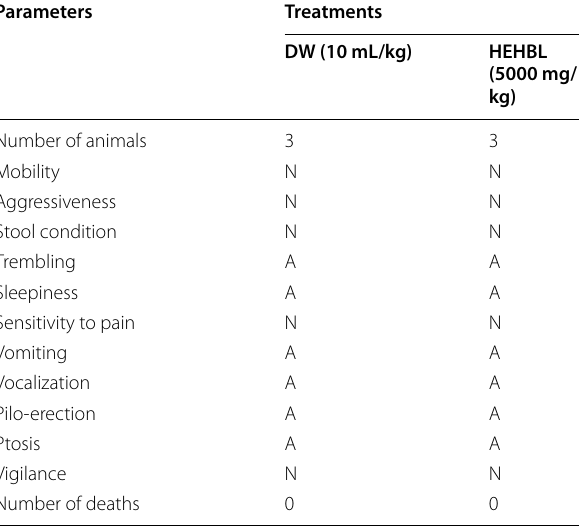
Table 4 Observed parameters during the assessment of acute toxicity